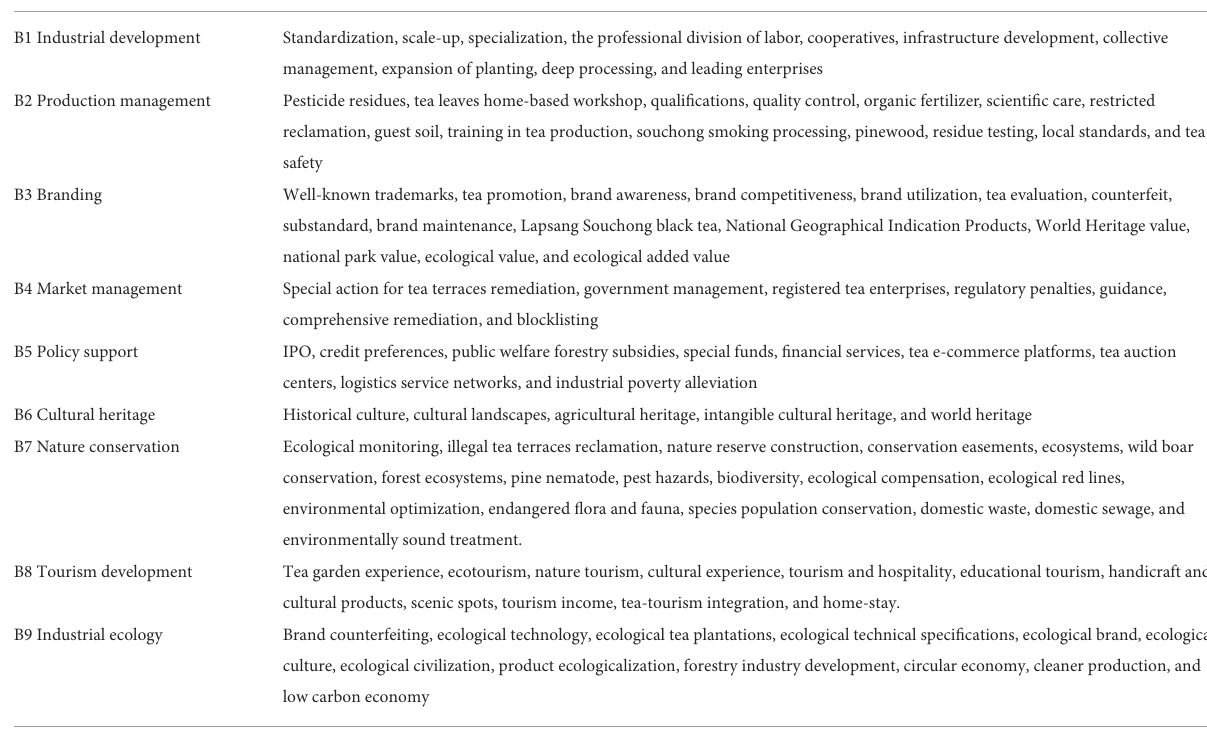
TABLE 2 The results of axial coding.